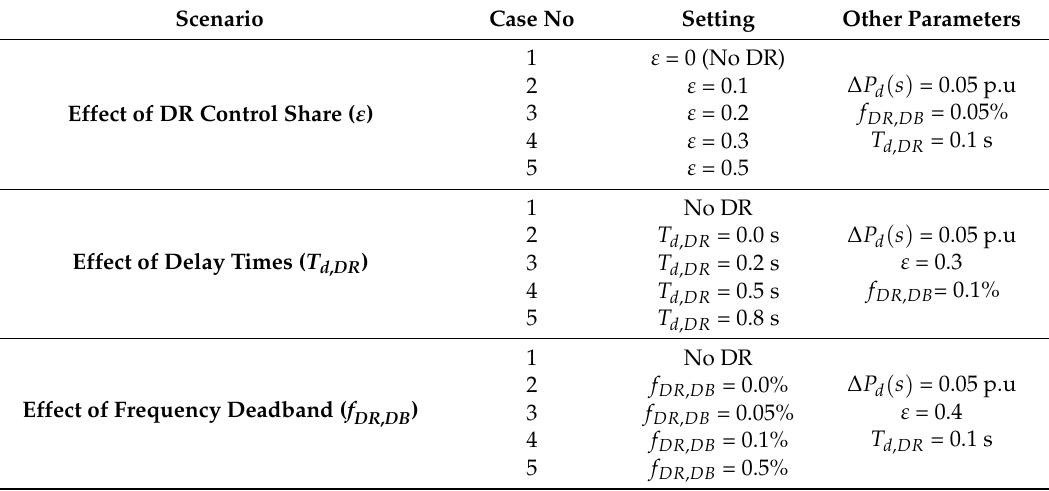
Table 2. DR control: simulation scenarios and parameter